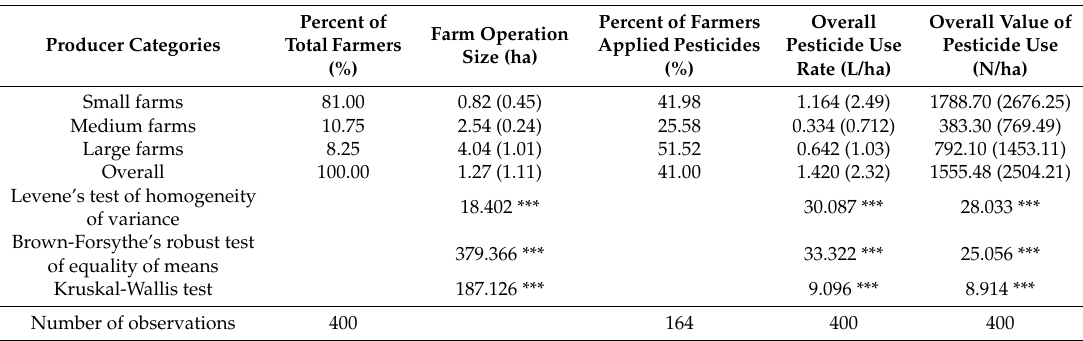
Table 4. Extent of pesticide use by farm size